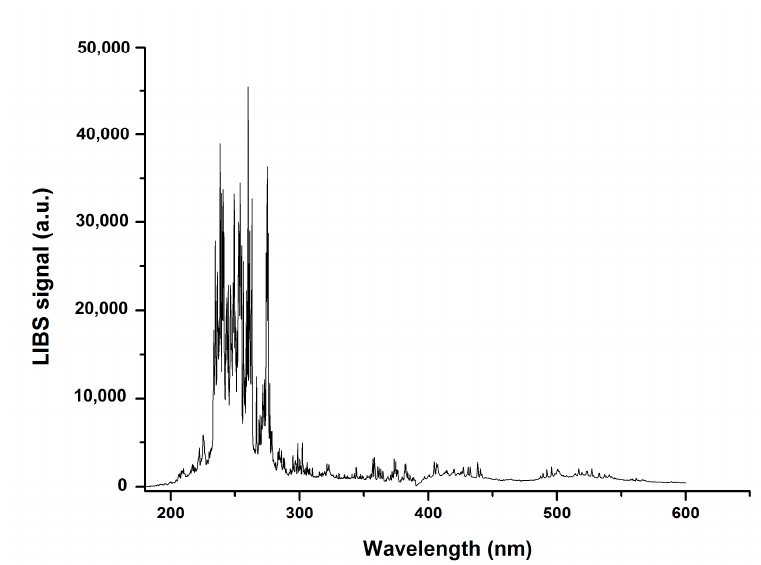
Figure 4. Typical LIBS spectrum acquired with the NanoLIBS h LIBS instrument for a pig iron sample.